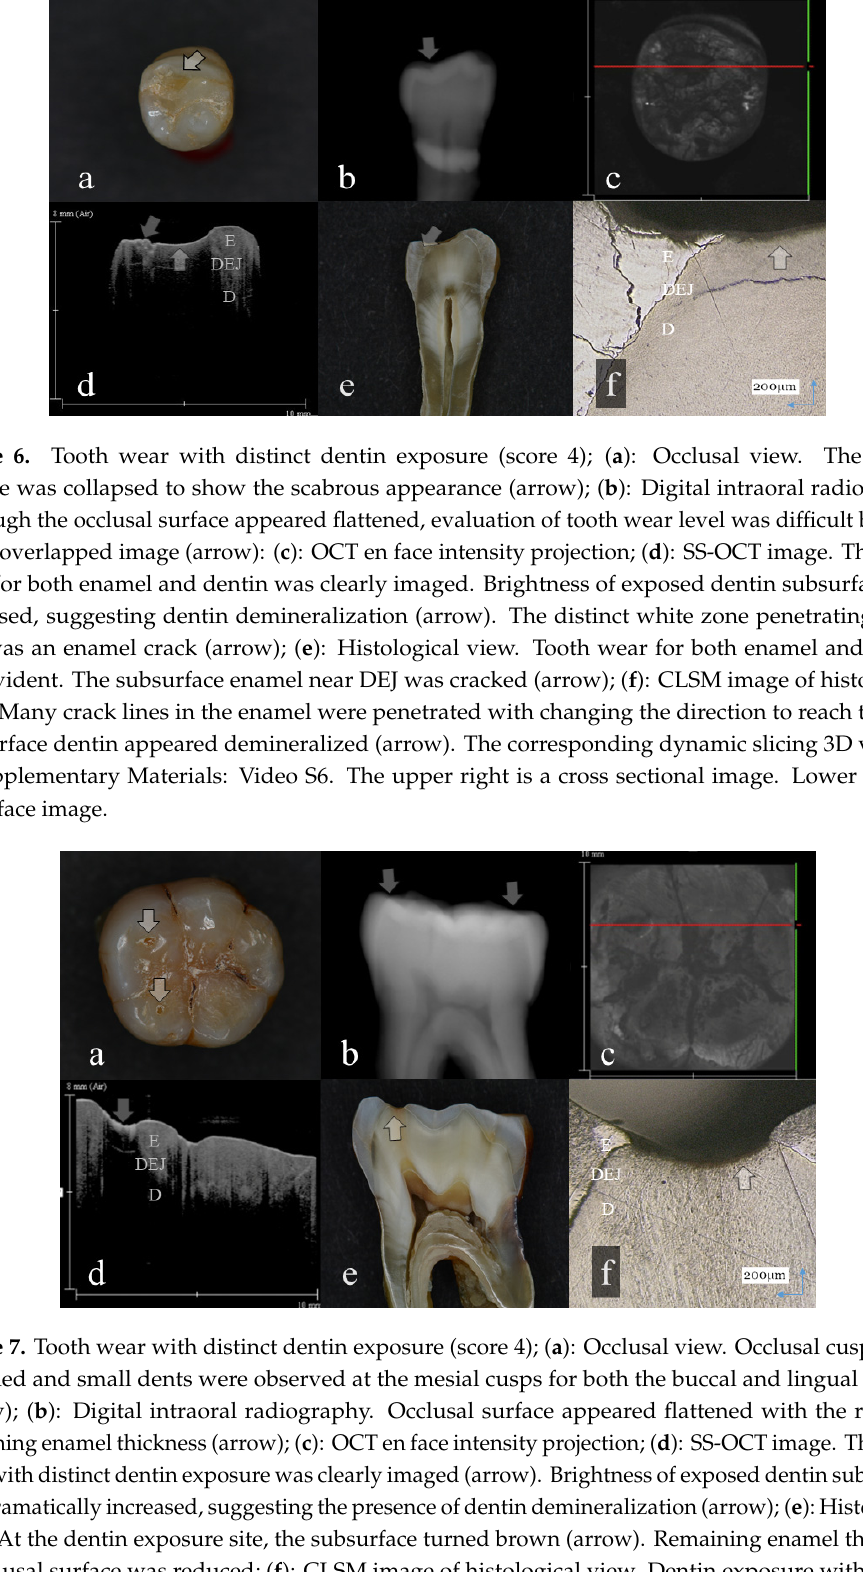
7 of 13 Figure 5. Tooth wear with distinct dentin exposure (score 4); ( a ): Occlusal view. Distal surface of buccal cusp was flattened with a brownish dot (arrow); ( b ): Digital intraoral radiography. In this radiography, buccal and lingual cusps were overlapped to disturb the tooth wear evaluation (arrow); ( c ): OCT en face intensity projection; ( d ): SS-OCT image. The tooth wear with the involvement of